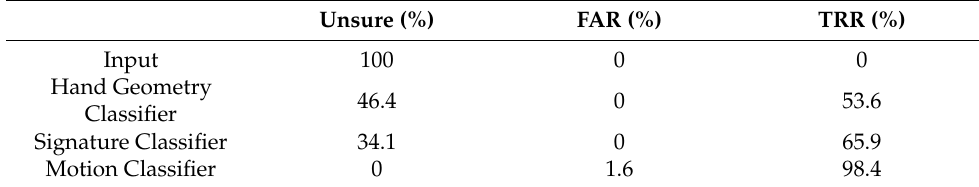
Table 2. Statistic table for forged data after each step of the